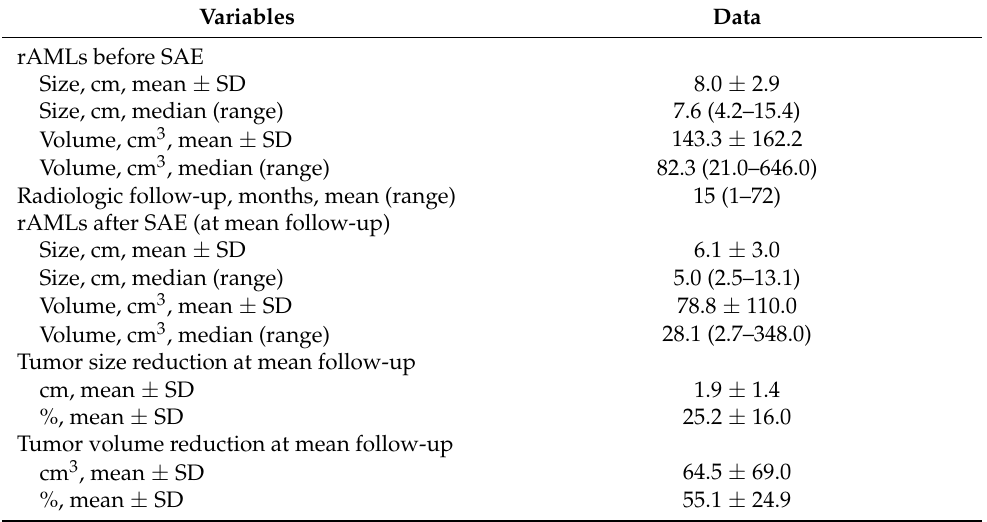
Table 2. Outcomes, follow-up, kidney function, and tumor size after selective arterial embolization (SAE) of one or more renal angiomyolipomas